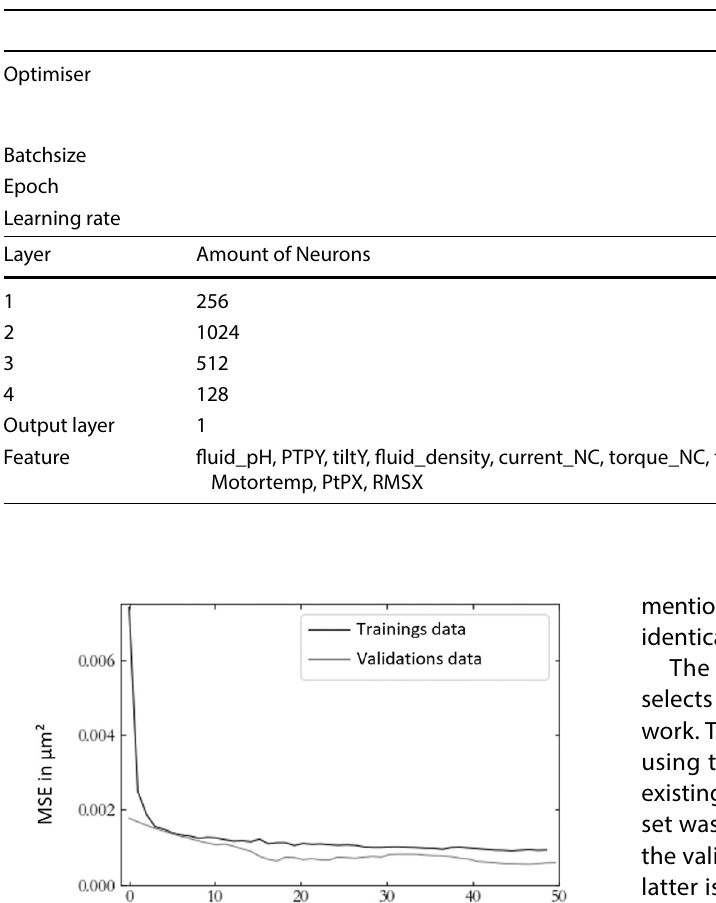
Table 3 Network used and the associated parameters